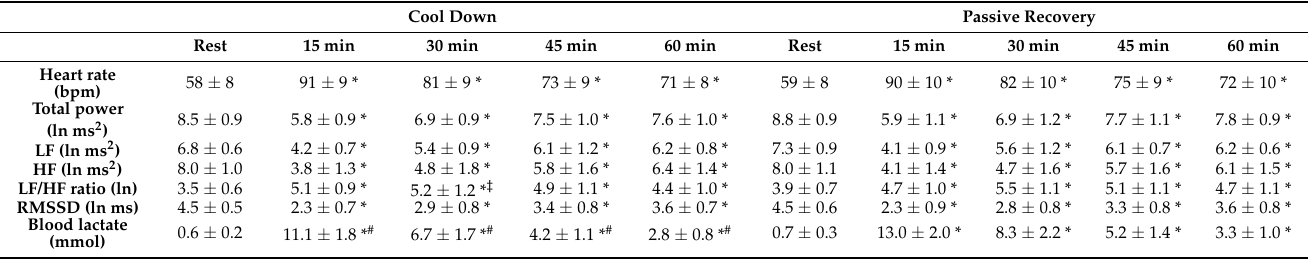
Table 2. Heart rate, autonomic variables, and blood lactate at Rest and during recovery from supramaximal interval exercise in moderately active individuals ( n = 16). Cool Down Passive